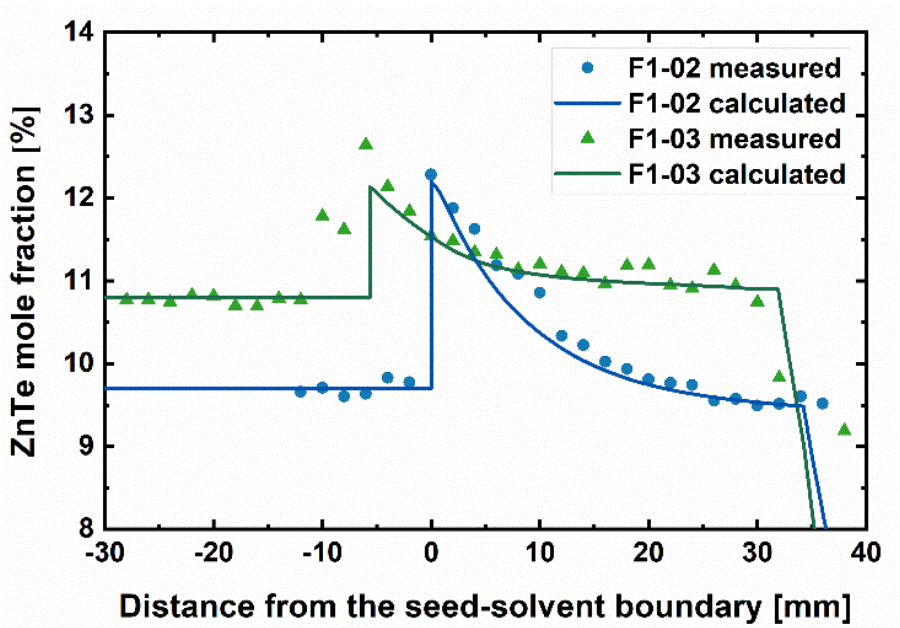
Figure 3. ZnTe content distributions along the growth direction of the crystals and calculated value from mathematical simulation [21]. ZnTe content variation at the interface of F1-02 is higher than that in F1-03. In both crystals, gradual reductions in the ZnTe content are observed as the growth/solidification